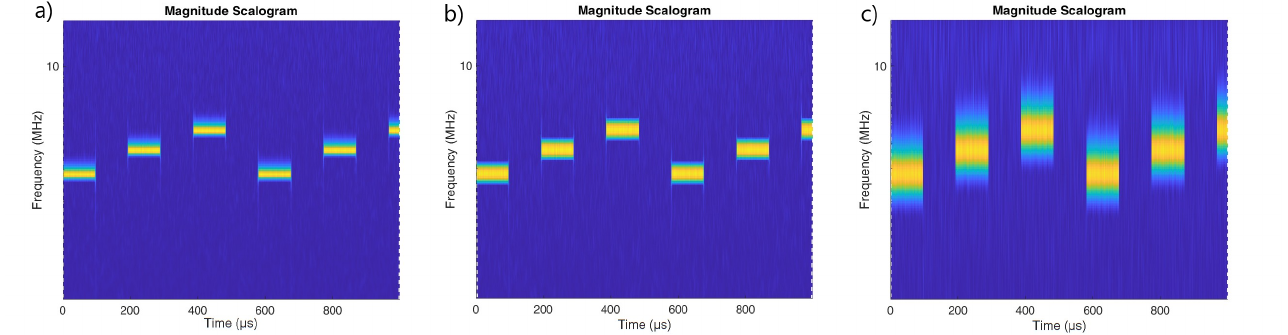
Figure 3. Scalogram for the PCCW signal made using wavelets: ( a ) Morse γ = 27, β = 27. ( b ) Bump ( c ) Morse (default parameters) γ = 3, β = 20.